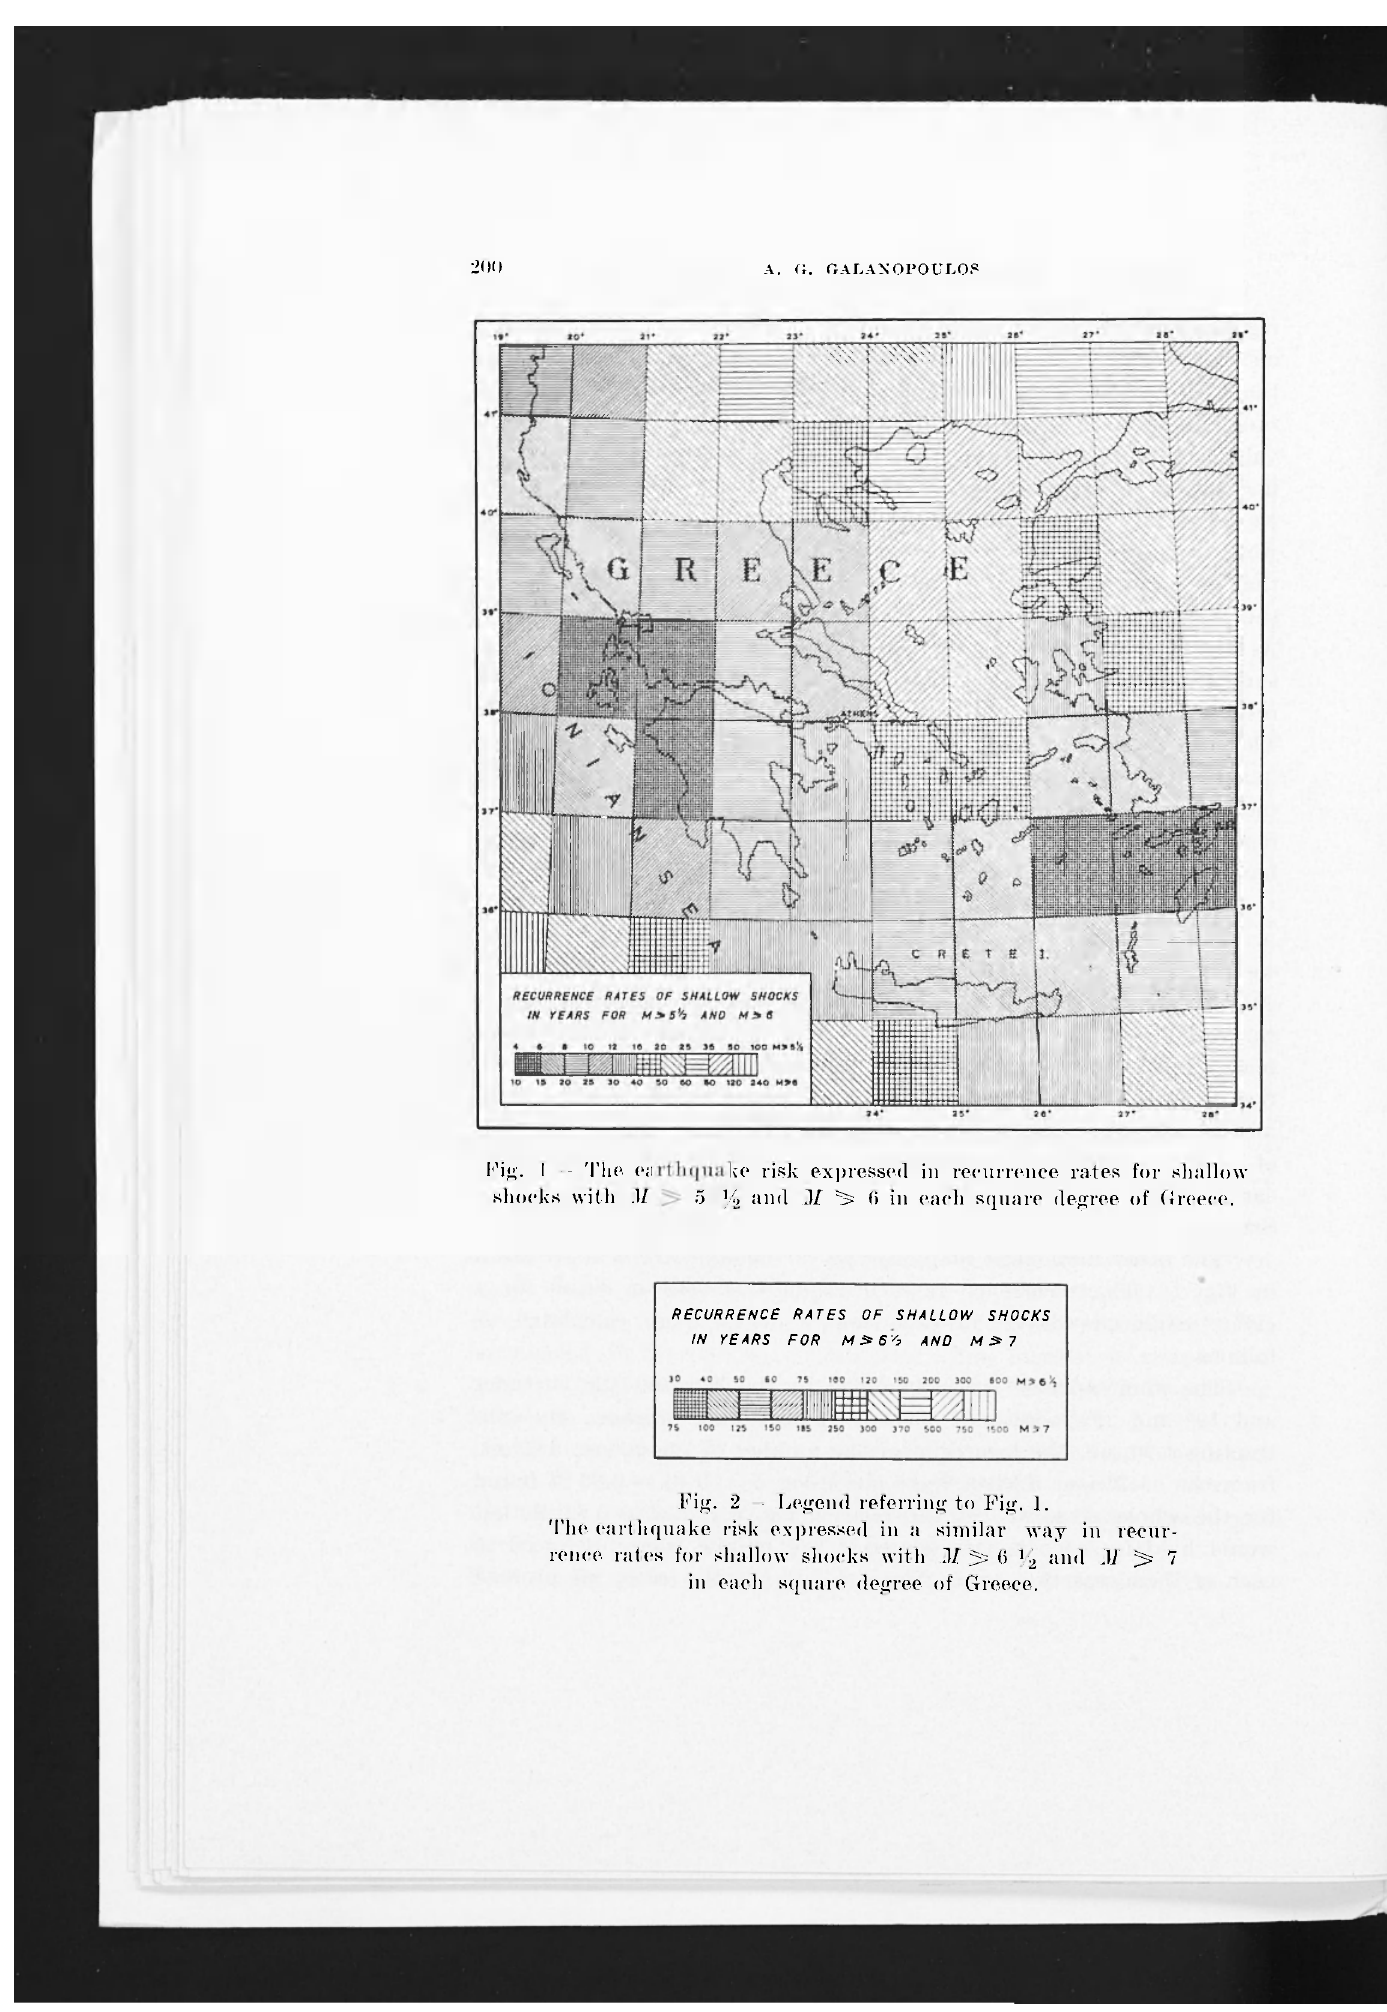
The earthquake risk expressed in a similar way in recur- rence rates for shallow shocks with M ^ 6 V 2 and M > 7 in each square degree of